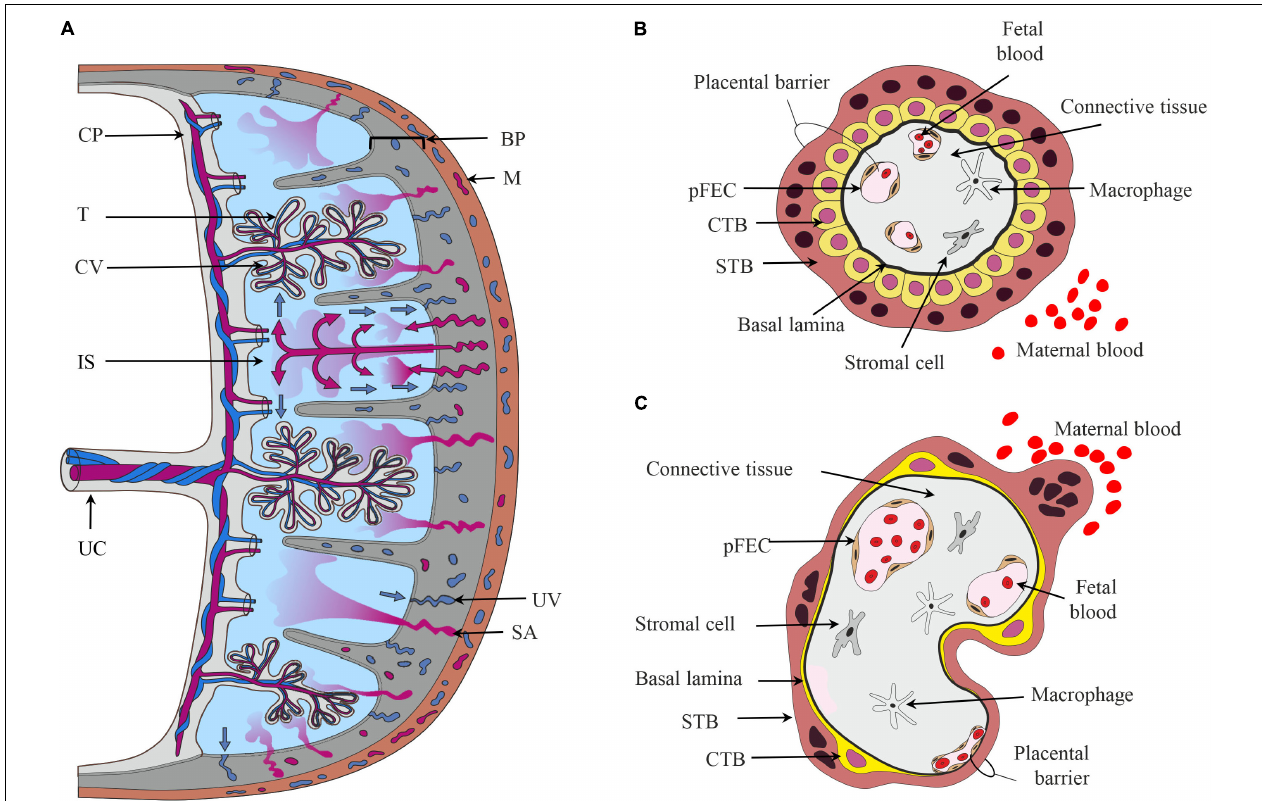
FIGURE 1 | The placental barrier. (A) Schematic depiction of the main structural elements of the human placenta. From the chorionic plate (CP), the umbilical cord (UC), and the chorionic villi (CV) originate. The umbilical vein carries oxygen- and nutrient-rich blood from the placenta to the fetus, while two arteries transport deoxygenated blood and waste products from the fetus to the placenta. The intervillous space (IS) is filled with maternal blood that enters this cavity via remodeled and opened maternal spiral arteries (SA) and leaves via uterine veins (UV). Cells in direct contact with maternal blood are the villous trophoblasts (T). The basal plate (BP) contains extravillous trophoblasts and decidual cells. (B,C) Schematic representation of first trimester (B) and term trimester chorionic villi (C) depicting the major cell types and the placental barrier. CTB , cytotrophoblast; M, myometrium of the maternal uterus, pFECs, placental-fetal endothelial cells; STB,